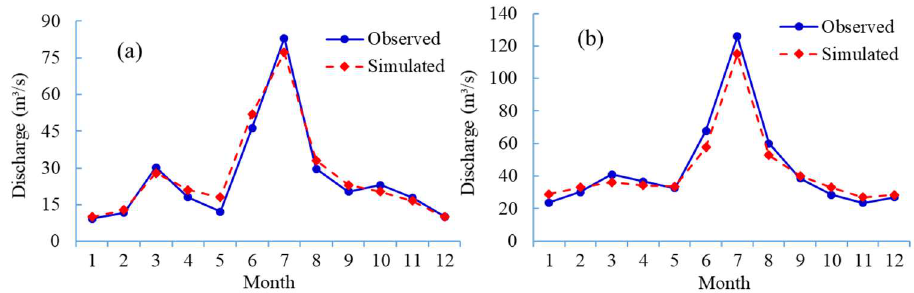
Figure 6. Comparisons between observed and simulated monthly discharge for the calibration period and validation period.